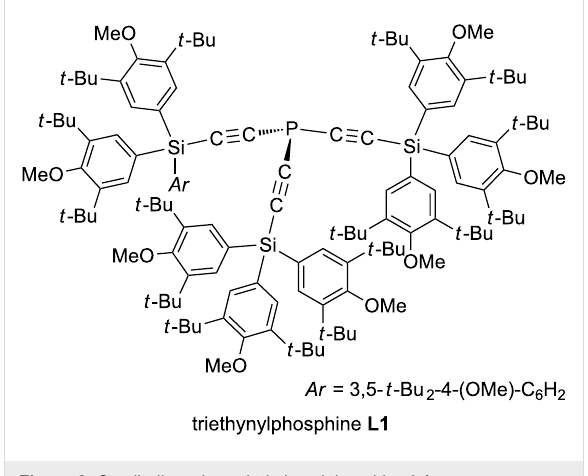
Figure 2: Semihollow-shaped triethynylphosphine L1